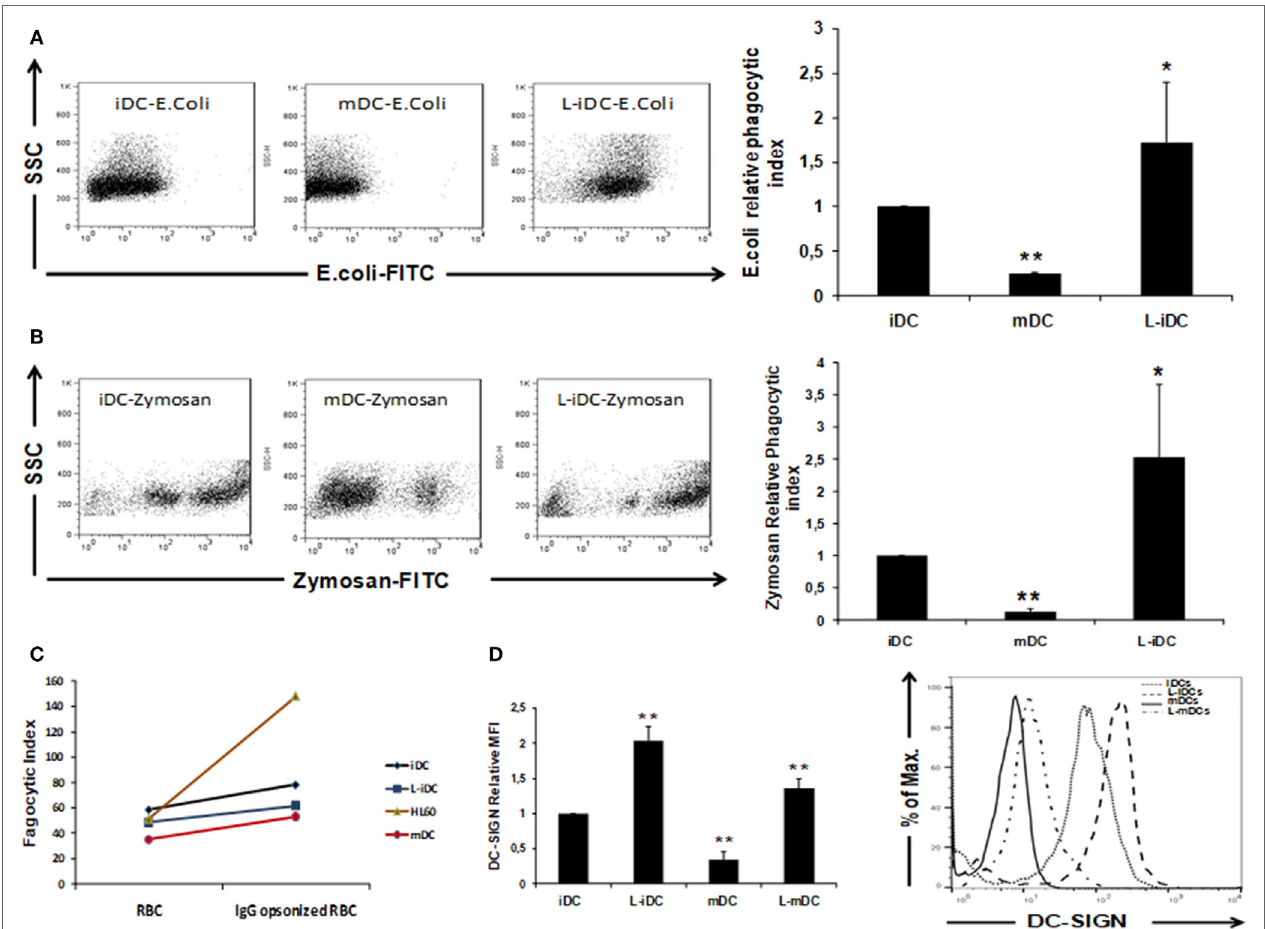
FigUre 4 | Phagocytosis of Escherichia coli and Zymosan is enhanced in L-iDCs. (a) Non-opsonized FITC-labeled E. coli was phagocytized more efficiently by L-iDCs than control DCs. The number of dendritic cells (DCs) showing green fluorescence was determined by flow cytometry. Left panel shows a Dot Plot with SSC vs FITC fluorescence from a representative experiment. Right panel shows the phagocytic index average of five independent experiments. Phagocytic index was calculated as (% positive cells × mean channel fluorescence). (B) Non-opsonized FITC-labeled Zymosan was phagocytized more efficiently by L-iDCs than control DCs. The number of DCs showing green fluorescence was determined by flow cytometry. Left panel shows a Dot Plot with SSC vs FITC fluorescence from a single experiment. Right panel shows the phagocytic index average of five independent experiments. (c) Green-labeled sheep red blood cells previously opsonized with human AB + serum were used to perform phagocytosis assays. HL60 cells were used as a control for opsonization-dependent phagocytosis. The number of DCs showing green fluorescence was determined by flow cytometry. The average of two independent experiments is shown. (D) DC-SIGN expression is upregulated on the surface of DCs differentiated in the presence of lenalidomide. Left panel shows the relative mean fluorescence intensity (MFI) ± SDs of three independent experiments. Right panel shows a representative histogram of a DC-SIGN staining (* p < 0.05; ** p <